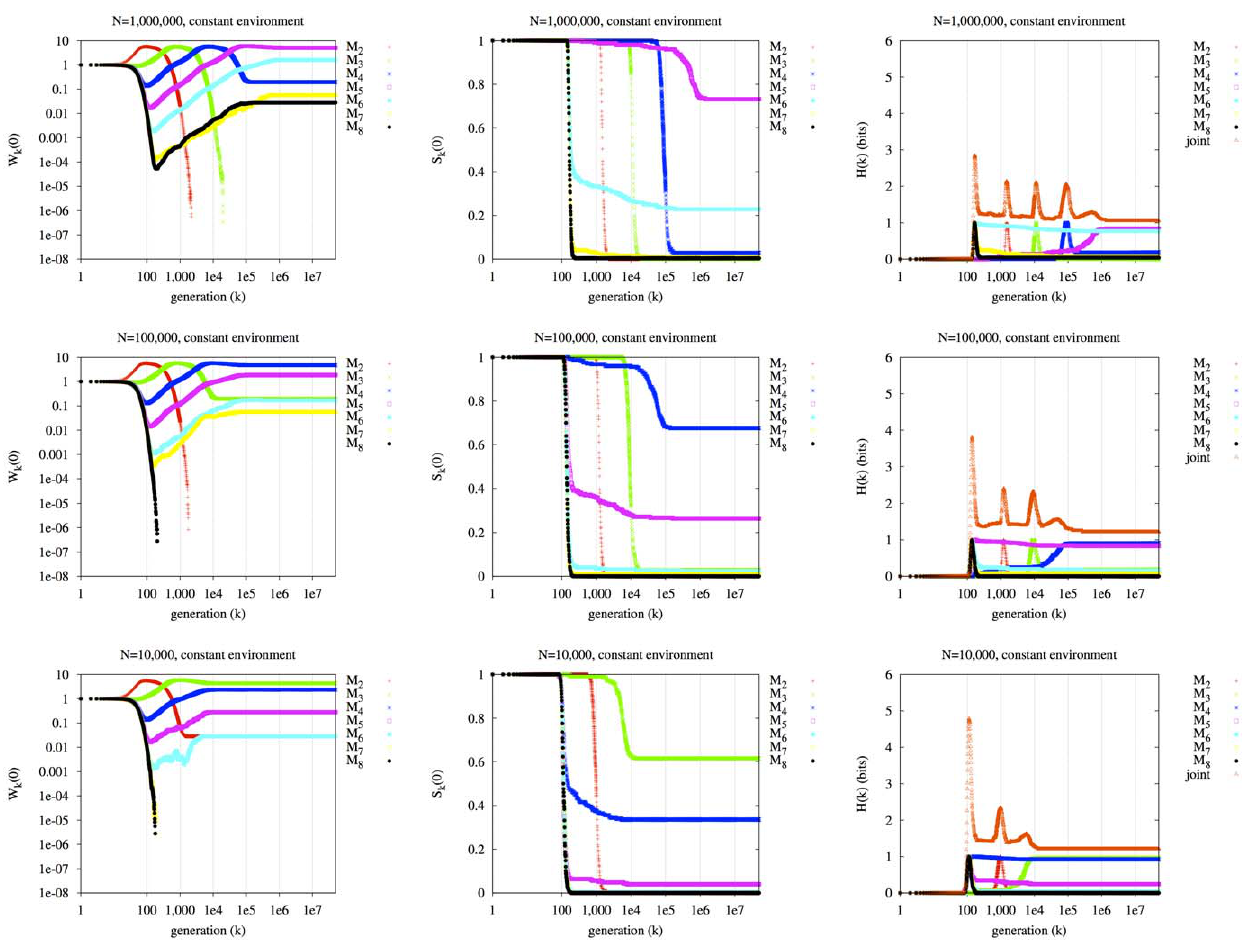
Figure 2. The effect of finite population size on the evolutionary dynamics of the seven mutator lineages. In rows: three values of N ( N =1,000,000, 100,000, 10,000). Left column: W k 0 ð Þ . Middle column: S k 0 ð Þ . Right column: H k ð Þ . No environmental switching.